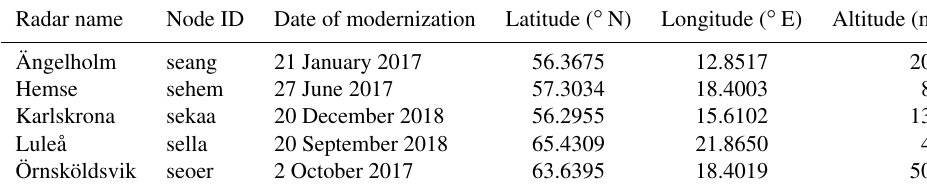
Table 1. Location and modernization dates for the weather radars selected for this work.